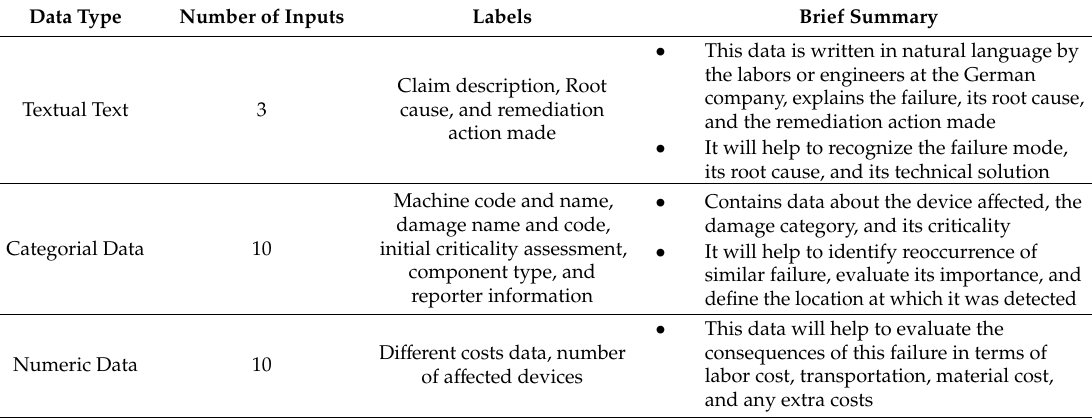
Table 1. Dataset input features for the machine learning